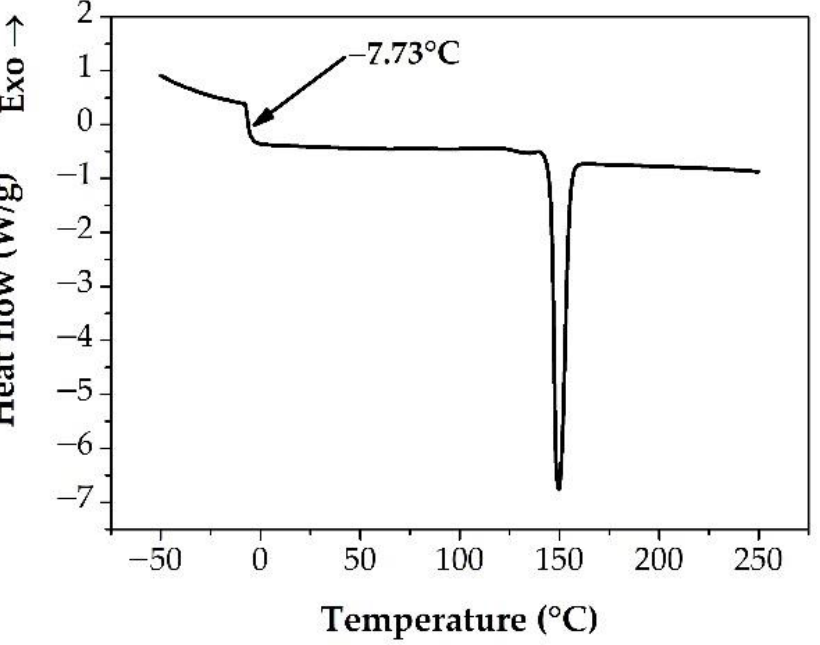
Figure 7. DSC thermogram of the measurement for T g determination of amorphous